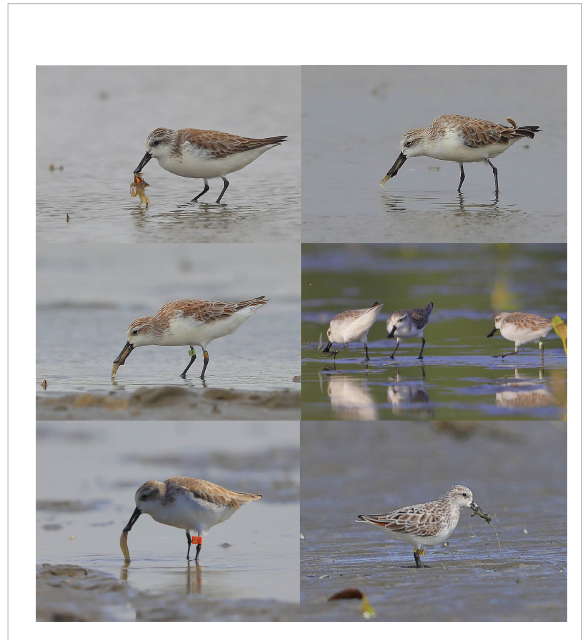
FIGURE 5 Photographs of Spoon-billed Sandpipers foraging in mud fl ats of Leizhou